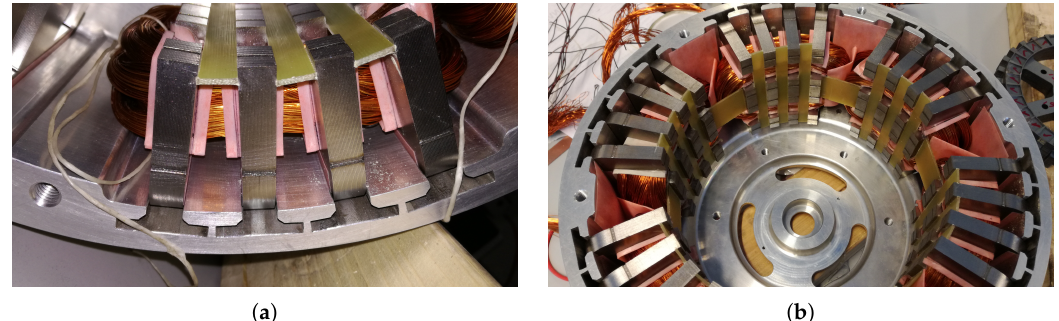
Figure 17. Assembly of the stator, ( a ) coils assembly, and ( b ) complete